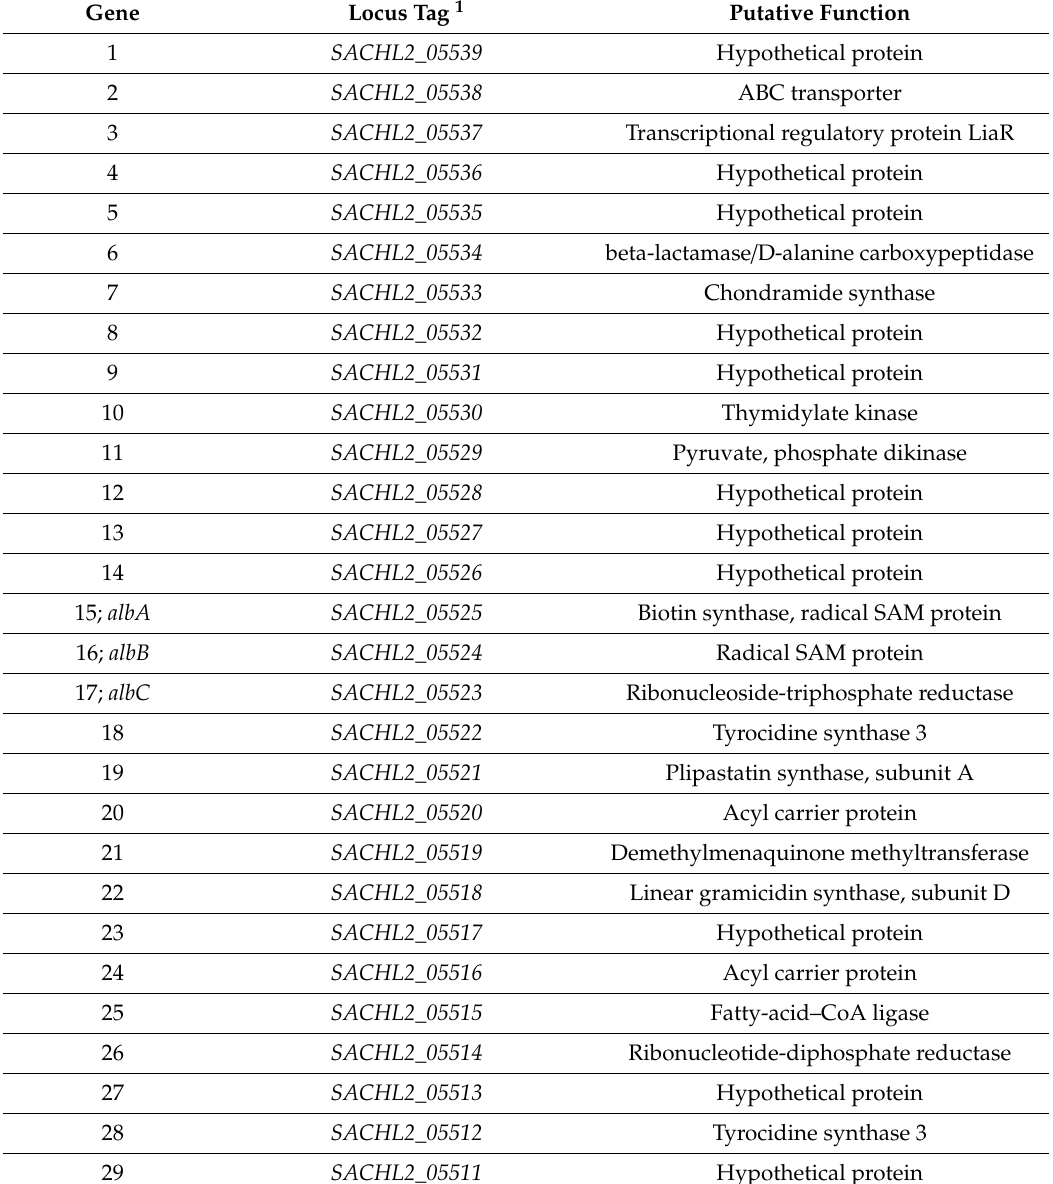
Table 1. Genes encoded within the chromosomal fragment cloned in BAC 1K1.